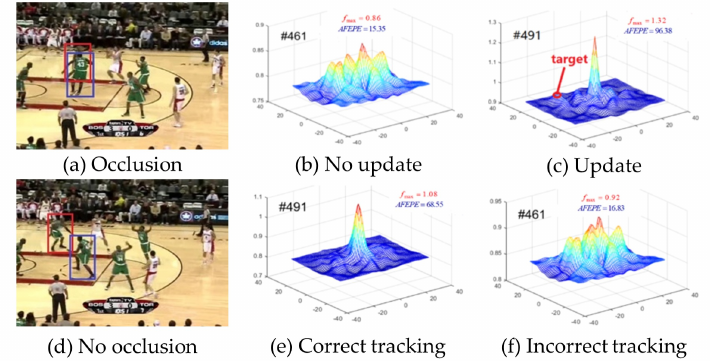
Figure 3. The effect of high-confidence judge